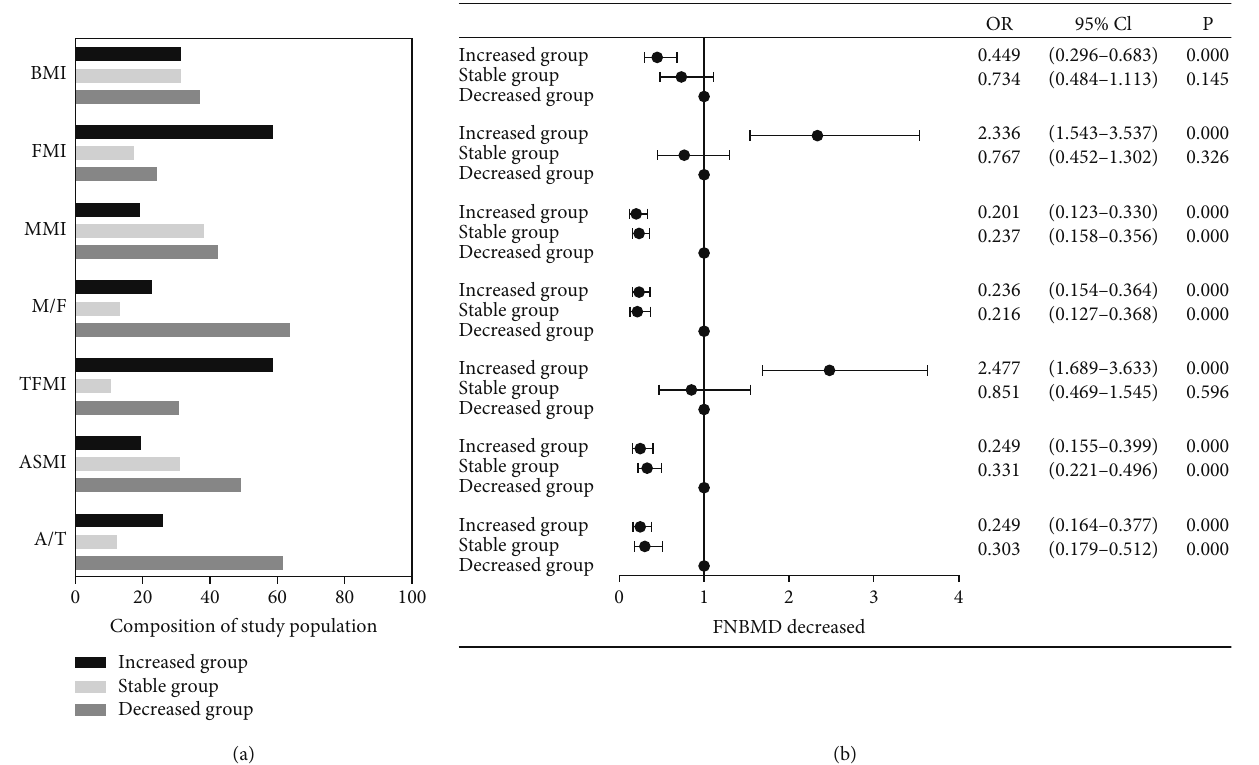
Figure 3: Binary logistic regression analysis of body mass index, body composition index, and FNBMD reduction. Note: adjusted: age, sex, course of T2DM, chronic complications of T2DM, BMI, FBG, HbA1c, TG, LDL-C, HDL-C, SBP, DBP, and medication history. FMI: fat mass index; MMI: muscle mass index; M/F: muscle/fat mass ratio; TFMI: trunk fat mass index; ASMI: appendicular skeletal muscle mass index; A/T: appendicular skeletal muscle mass/trunk fat mass